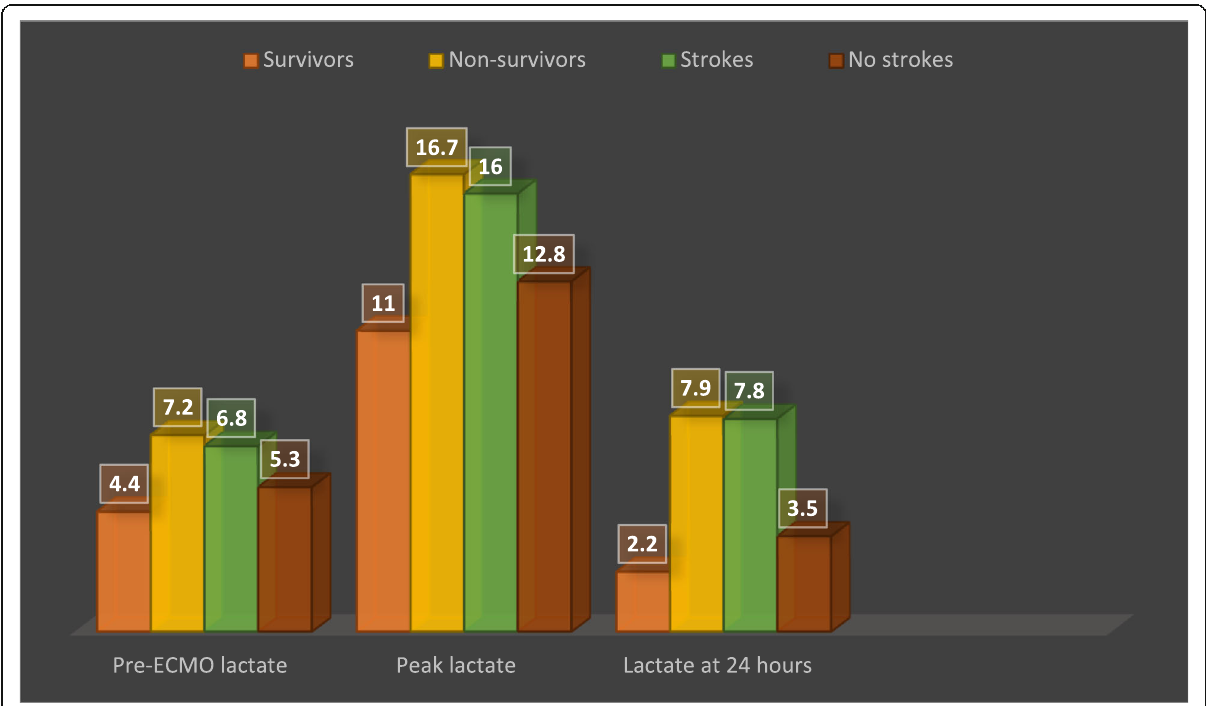
Fig. 1 The mean blood lactate levels of studied VA-ECMO-treated